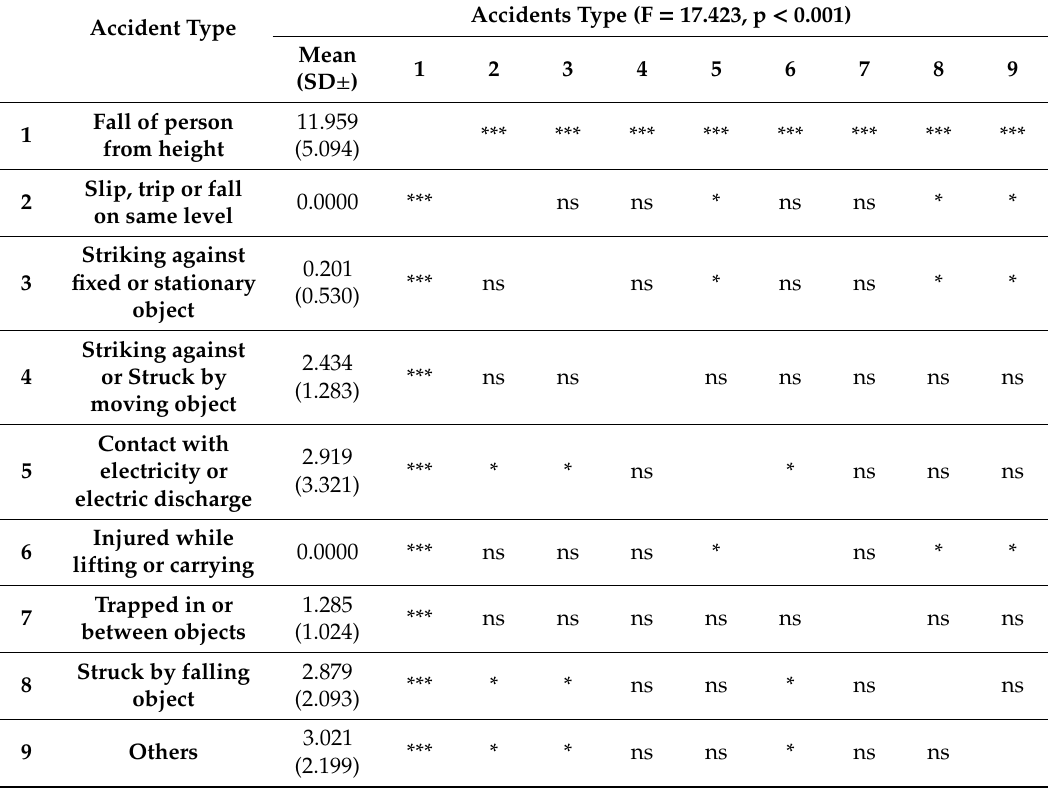
Table 5. Result of ANOVA analysis based on mortality rates